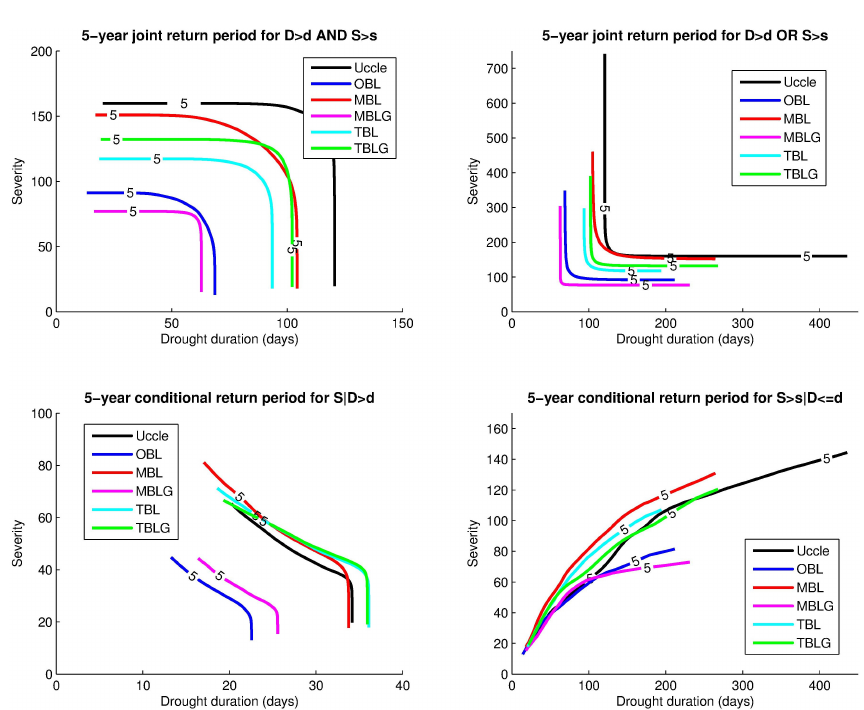
Fig. 9. 5yr return period for droughts simulated by Uccle (black), OBL (blue), MBL (red), MBLG (pink), TBL (cyan) and TBLG (green) with { D ≥ d AND S ≥ s } (left, above panel); { D ≥ d OR S ≥ s } (right, above panel); { S | D >d } (left, below panel); and { S >s | D ≤ d } (right, below